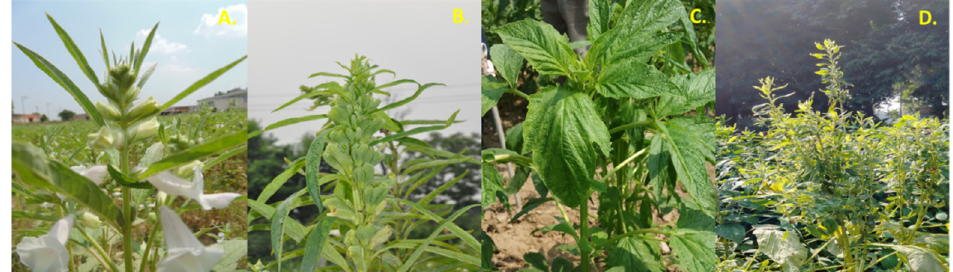
Figure 1. Sesamum indicum L . plants ( A ) Asymptomatic flowering twig (HF) ( B ) Symptomatic twig showing phyllody (I1) ( C ) Asymptomatic vegetative twig (H1) ( D ) twig showing little leaf symptom (LL).